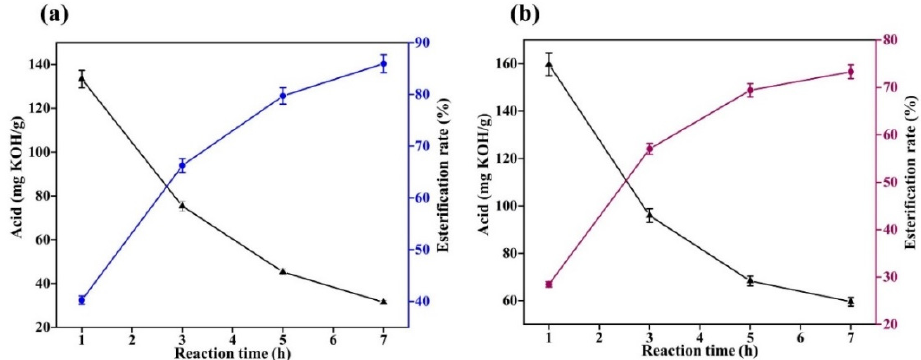
Figure 3. Esterification results of methanol with oleic acid at 90 °C ( a ): sodium hydroxide; and ( b ): sulfamic acid.